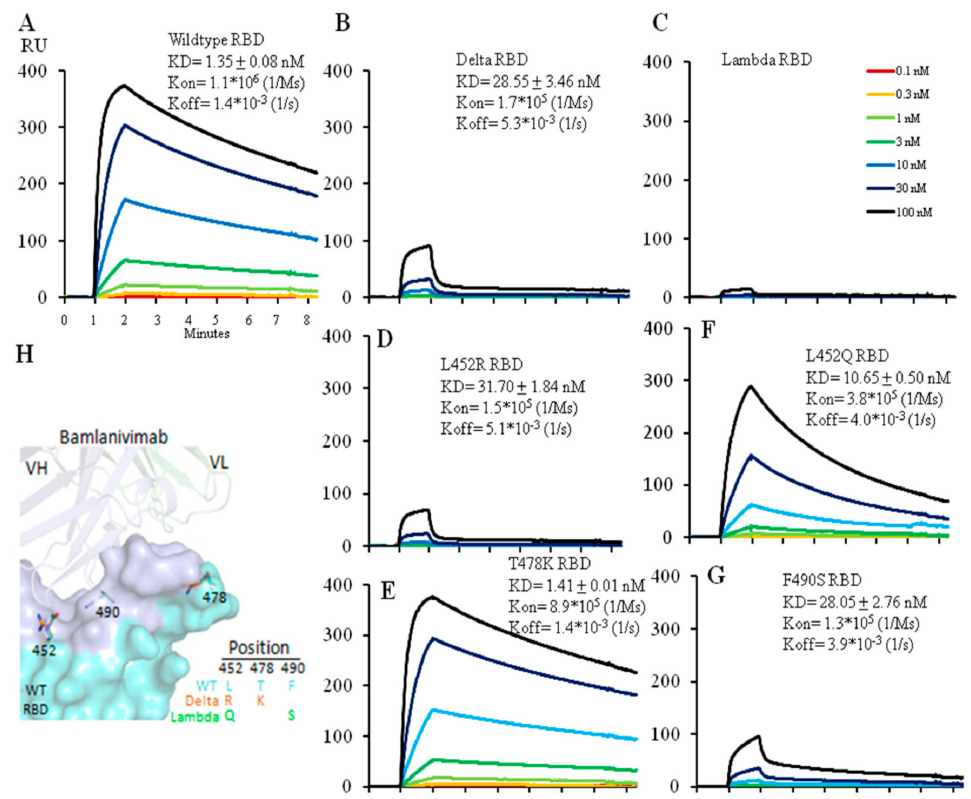
Figure 2. Affinity measurement of Bamlanivimab binding to wild type ( A ), Delta ( B ) or Lambda ( C ) RBD with Biacore. Bamlanivimab binding to RBDs with a single amino acid mutation was also measured to dissect each mutation’s contribution to Bamlanivimab binding with two Delta mutations L452R ( D ), T478K ( E ), and two Lambda mutations L452Q ( F ) and F490S ( G ). The protein model for Bamlanivimab and RBD is shown in ( H ) with the Bamlanivimab footprint on RBD in light blue while the other part of RBD in cyan. 7KMG (PDB ID) was used for modeling. Note that all the Biacore figures have the same x-axis unit as in the ( A